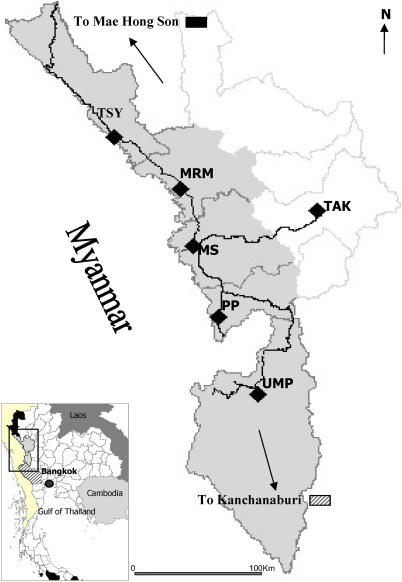
Map of Tak ProvinceThe study area is shown in grey.